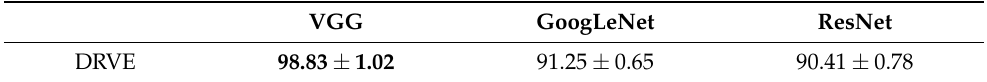
Table 1. Recognition rate (%) of DRVE with different pre-trained